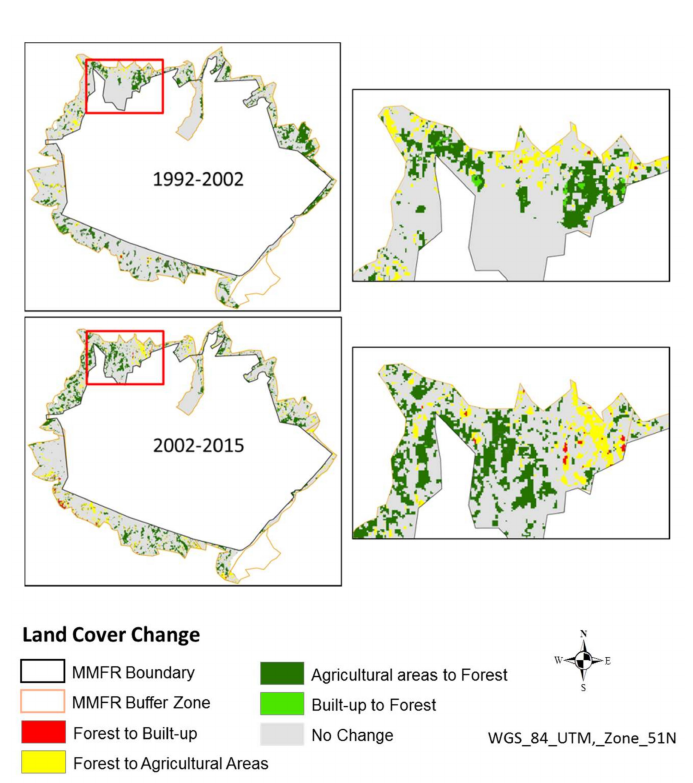
Figure 7. Change Maps of MMFR Buffer Zone from 1992–2002 and 2002–2015. The two insets show the same zoomed area for its land cover